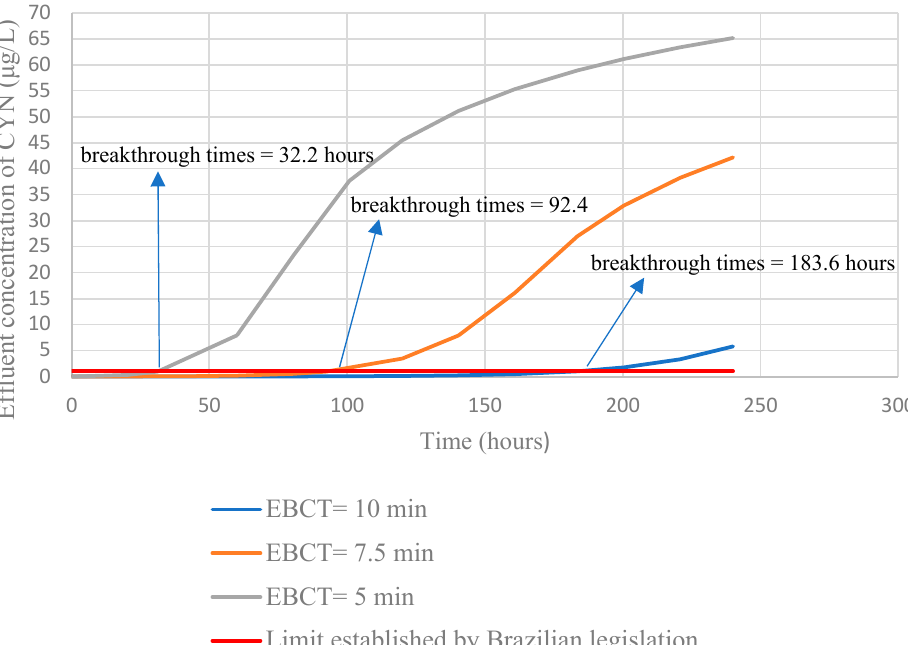
Figure 13. Simulation of the full-scale GAC adsorbent column operating with different EBCTs. Input values used in the model: Apparent bed density = 0.476 g/cm 3 ; Grain density = 0.850 g/cm 3 ; Average grain diameter = 0.855 mm; Initial CYN concentration = 100 μ g/L; Flow = 700 L/s; Equilibrium coefficients (Langmuir isotherm) q max = 3430 μ g/g, KL = 0.31 L/ μ g; Mass transfer coefficients D (cid:2929) = 3 × 10 (cid:2879)(cid:2869)(cid:2874) m 2 /s e K (cid:2916) = 9 × 10 (cid:2879)(cid:2874) m/s.